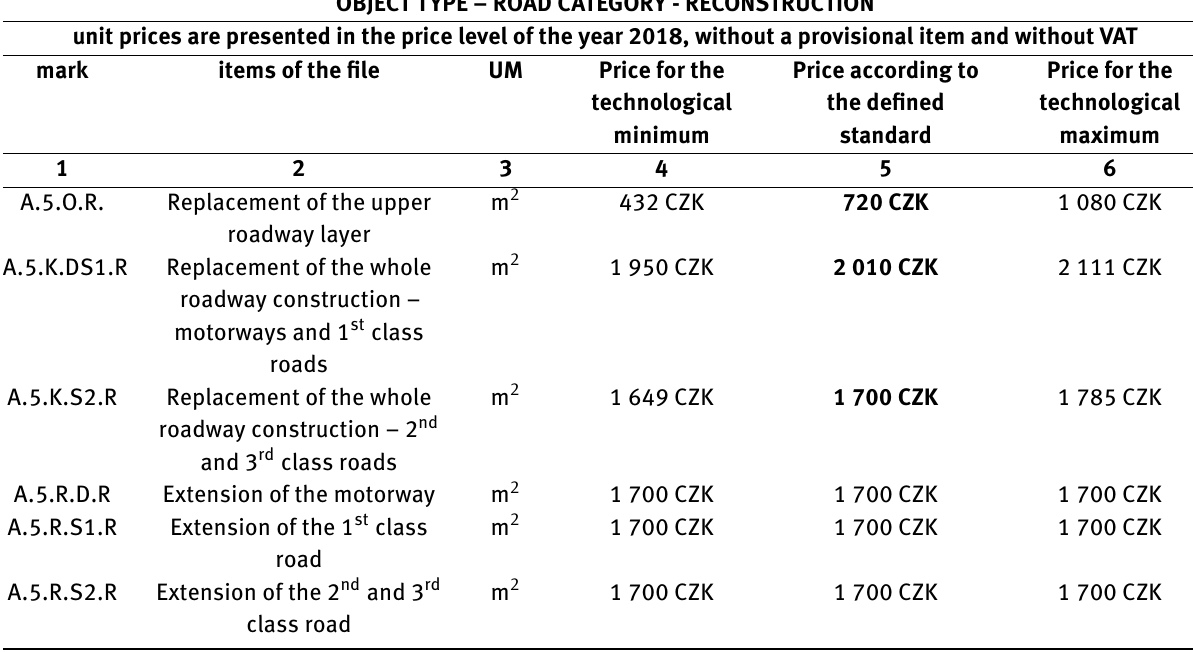
Table 3: Cost databases for the assessment of road constructions in 2018 [16, 17] OBJECT TYPE – ROAD CATEGORY - RECONSTRUCTION unit prices are presented in the price level of the year 2018, without a provisional item and without VAT